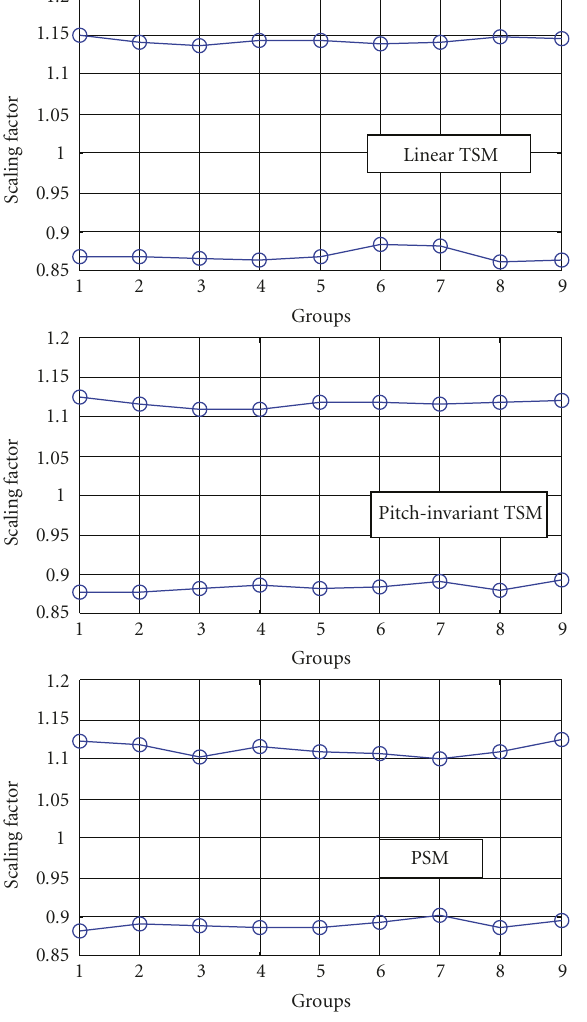
Figure 13: Average upper and lower bounds, watermark length = 10. or insertion errors marked by bold and deletion errors marked by underlines)